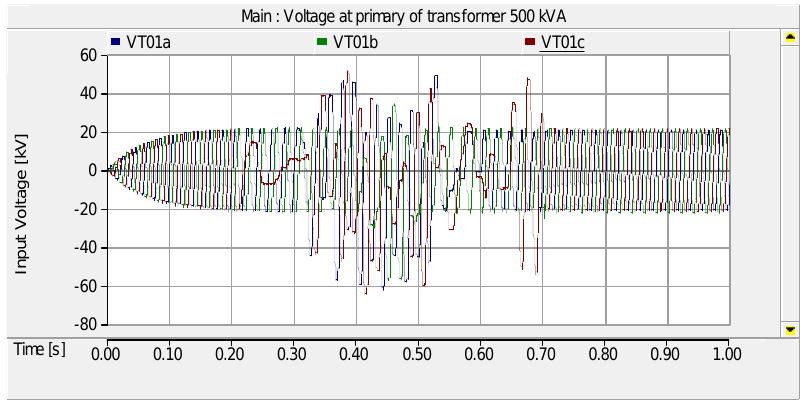
Figure 14. The ferroresonance overvoltage at the HV side transformer 500 kVA.